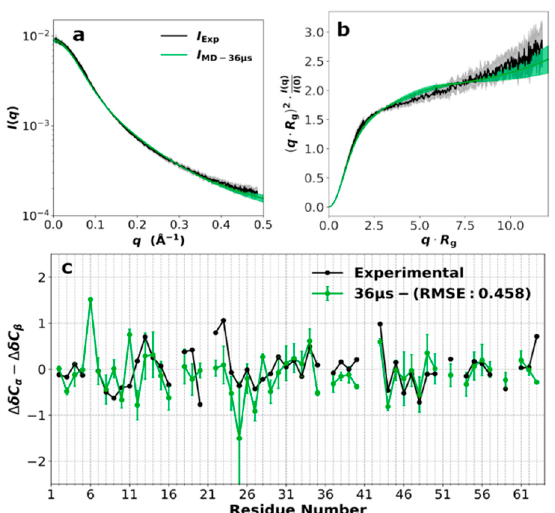
Figure 2. Small-angle X-ray scattering (SAXS) profile and secondary chemical shifts. ( a ) Scattering intensity I ( q ); ( b ) Kratky plot; ( c ) secondary chemical shifts. Experimental data are shown in black, while the predictions from the 36- μ s AMBER14SB/TIP4PD simulations are in green.